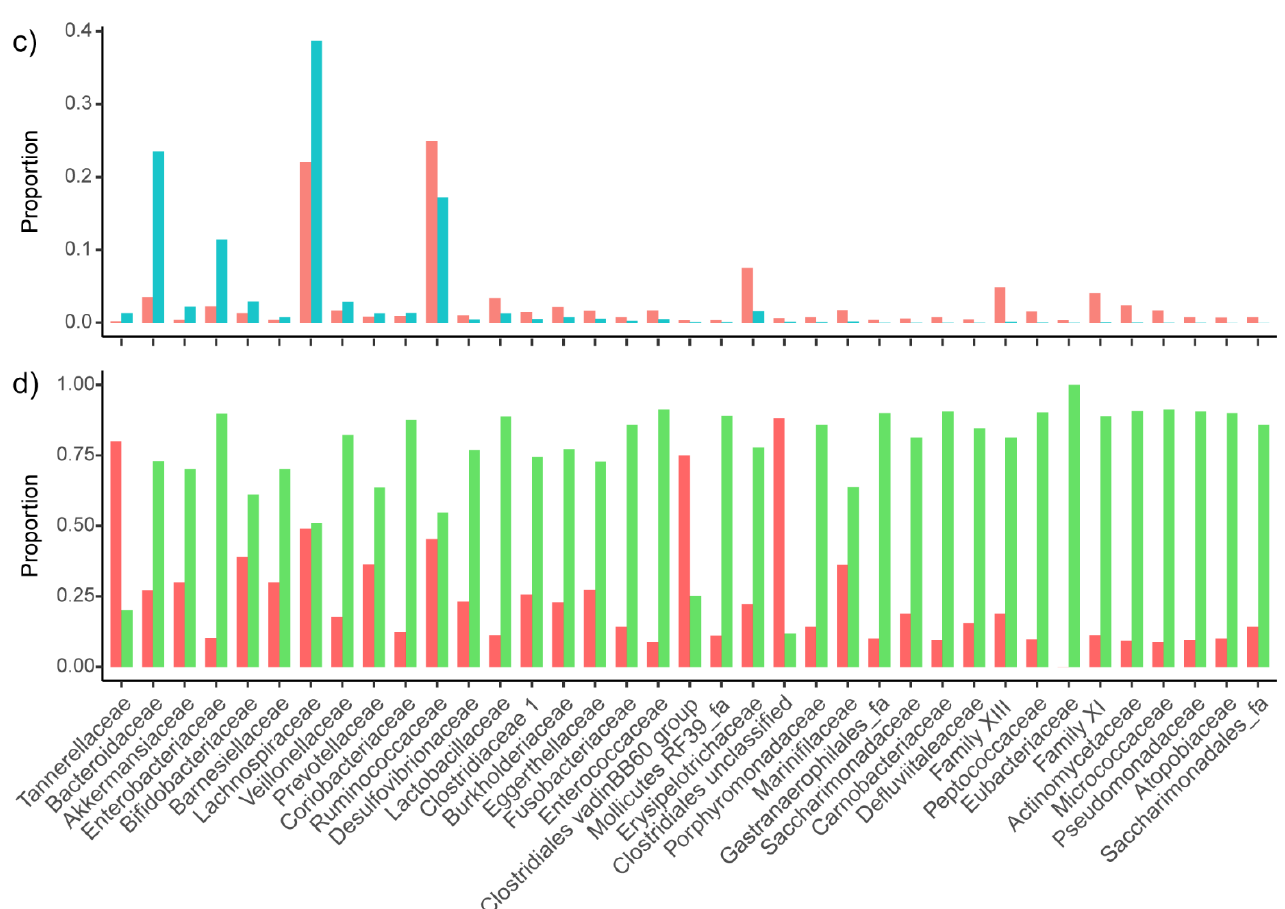
Figure 7. Taxa whose proportions of associations were significantly over- or under-represented compared to the overall distribution of OTU-counts at: ( a ) class; and ( c ) family level as determined by Fisher exact test; proportion of positive and negative associations for: ( b ) class level; and ( d ) family level. Bars are ordered by the ratio of associations to counts and negative to positive associations,